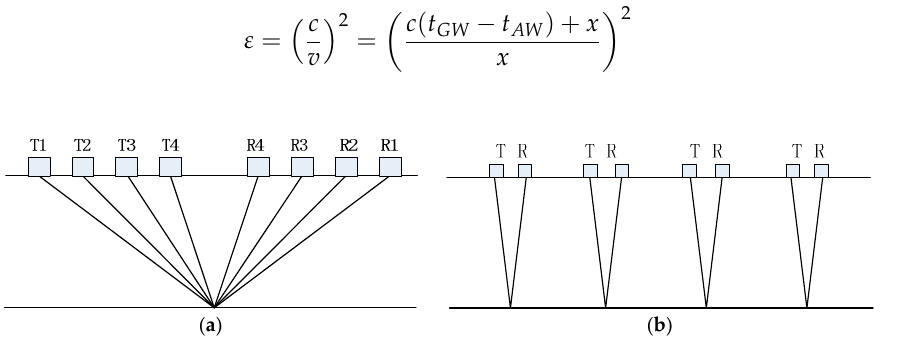
Figure 2. Schematic diagram of CMP method ( a ) and FO method ( b ).